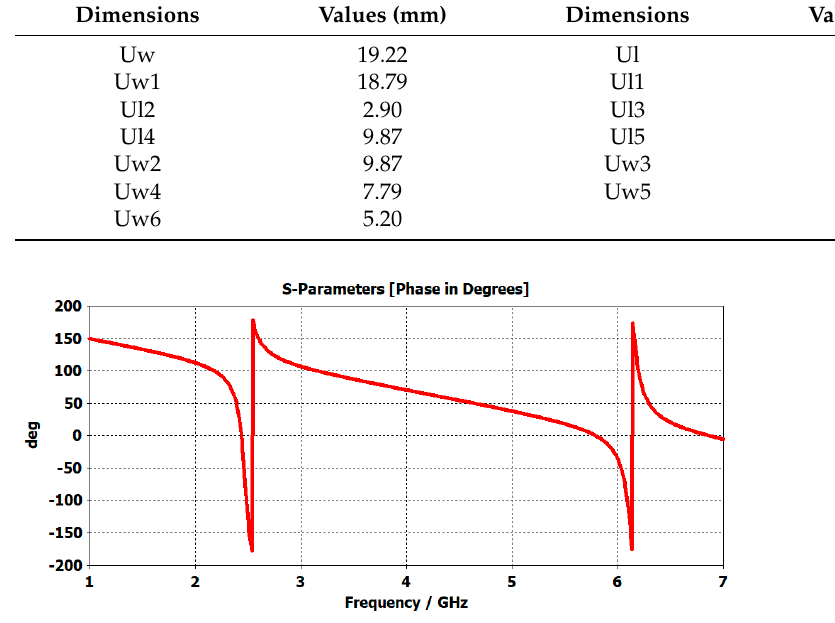
( b ) Figure 14. Surface current distribution of the AMC unit cell at: ( a ) 2.45 GHz; ( b ) 5.8 GHz. 3.2. Parametric Analysis of the AMC Unit Cell Three key parameters of the AMC unit cell are studied in this section: the length of the inner square patch ‘ ul4 ′ , the lower width of the outer square patch ’uw5 ′ and its upper width ‘uw3 ′ . Figure 15a illustrates that when length ‘ul4 ′ was changed from 8.87 to 10.87 mm, the zero-phase difference does not change at the upper frequency band. However, it slightly changes in the lower band as it starts moving towards the frequency of 3 GHz when the length is increased, and the optimum value is obtained at 9.87 mm. Thus, this value is taken as the length of the inner patch in the design of the unit cell. When ‘ uw5 ′ , the lower width of the outer patch, was changed from 7.10 to 9.10 mm, it can be seen from the parametric graph that a slight shift is observed; the phase difference at the lower band shifts below the desired frequency and at the upper band shifts beyond the desired fre- quency. An optimum value of 8.10 mm was used for this design, at which better results were obtained.